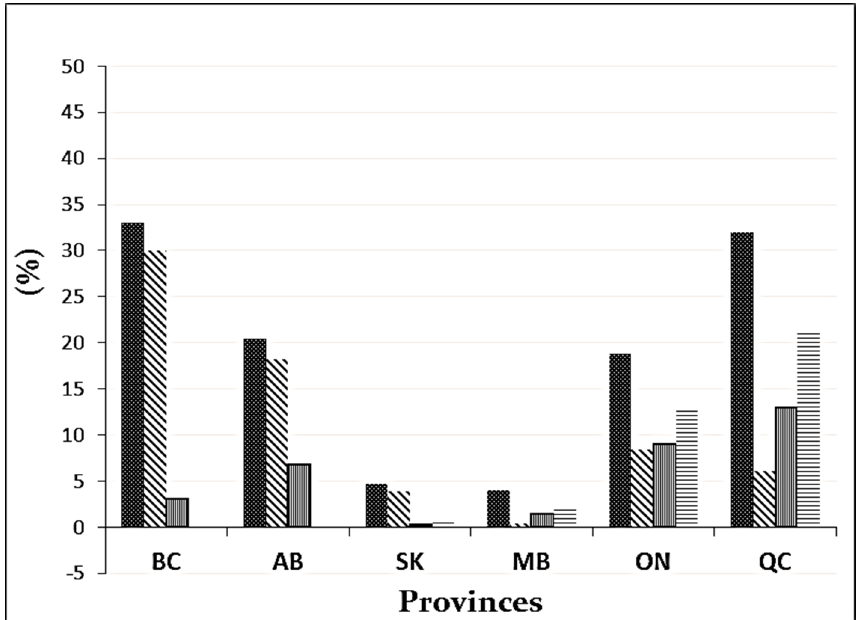
Figure 3. Frequency of occurrence (%) of aspen stands with conifer